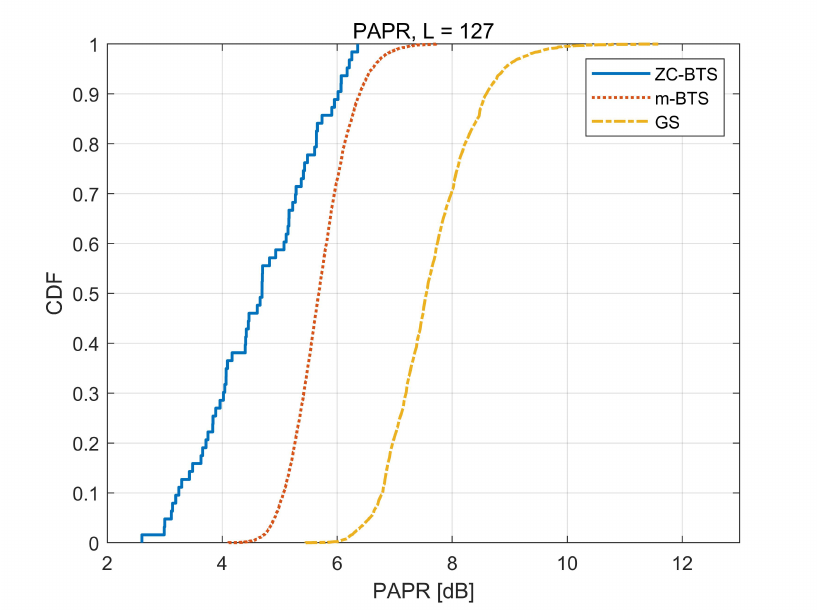
Figure 6. PAPR for three